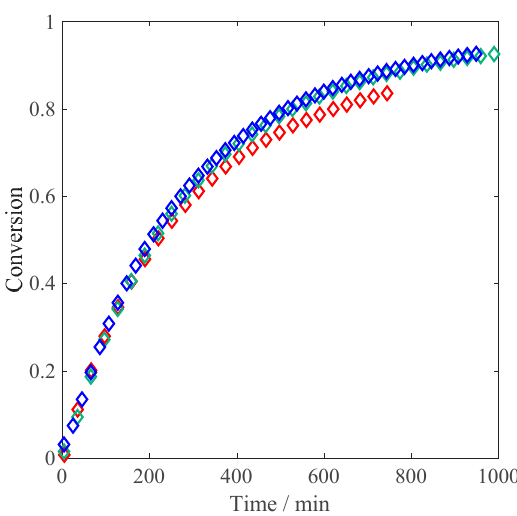
Figure 5. Monomer conversion versus time profiles of the radical batch polymerization of fully ionized MAA in aqueous solution at 50 °C, 0.1 wt % of V ‐ 50 initiator and constant ionic strength equivalent to 10 wt % MAA by addition of NaCl. Variation of monomer concentration: 1 wt % (red), 5 wt % (green), and 10 wt % (blue, no NaCl addition).